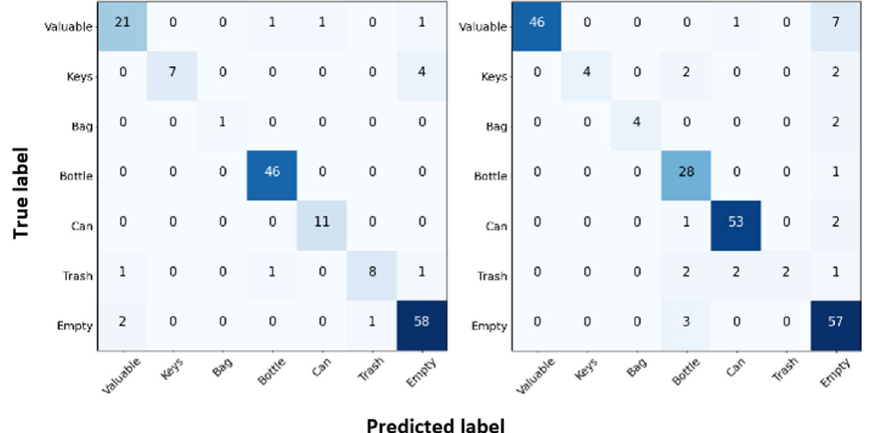
Fig. 22 Confusion matrices for test images obtained from the SEAT concept car (left) and Aalto research vehicle